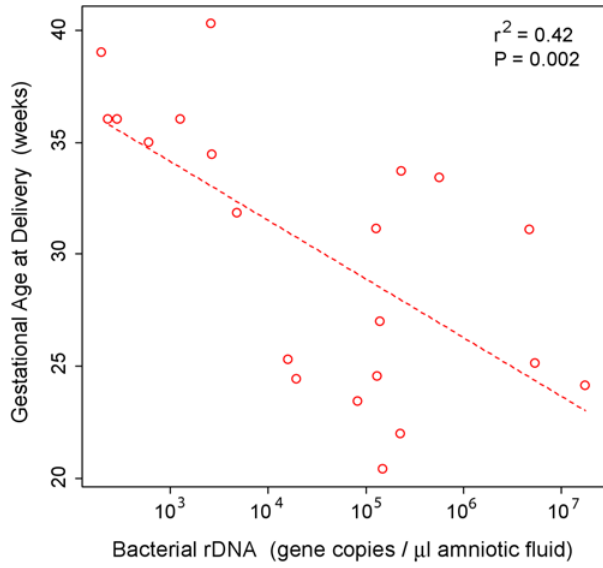
Figure 5. Gestational Age at Delivery as a Function of Bacterial rDNA Concentration. Data are for samples yielding detectable results within the sensitivity and dynamic range of the real-time PCR assay ( , 250–1 6 10 8 genes/ m l amniotic fluid). doi:10.1371/journal.pone.0003056.g005 PLoS ONE |